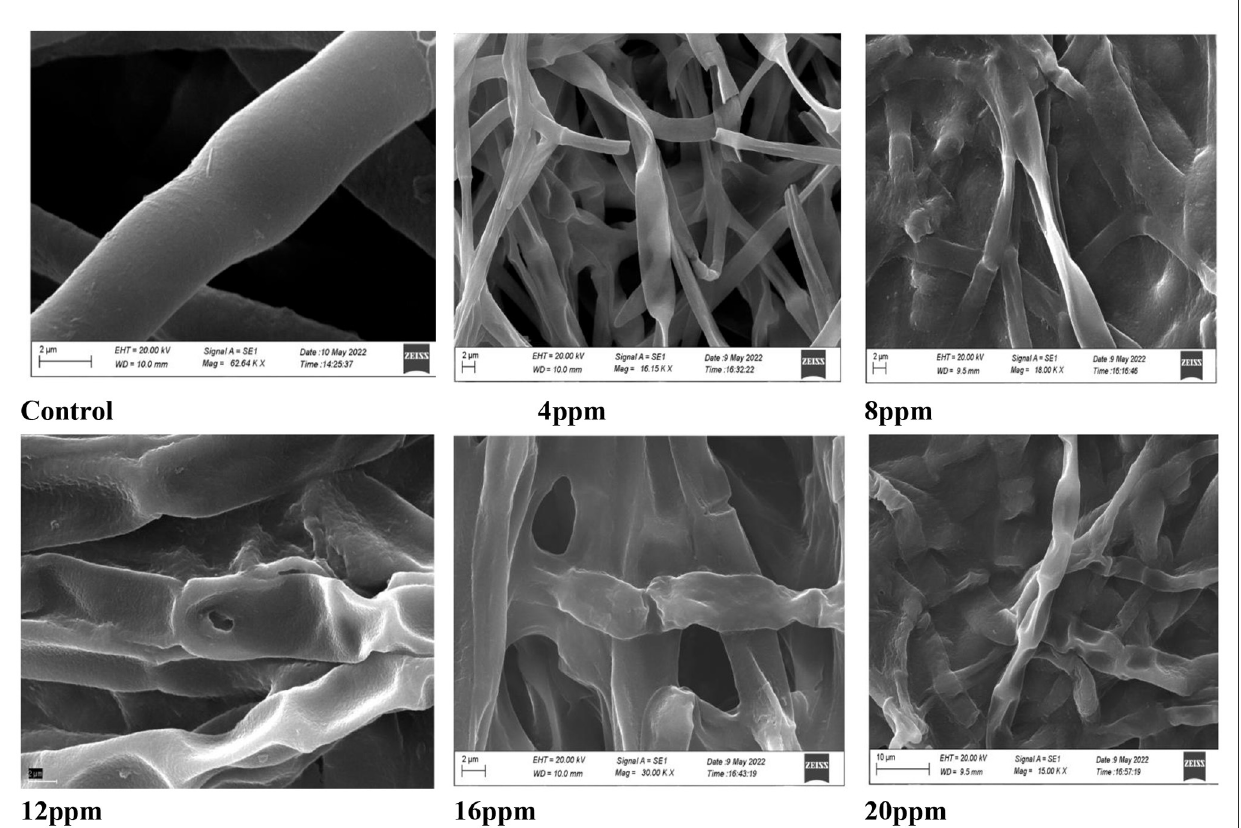
FIGURE11 Field study experimental plot at the Institute of Agricultural Sciences, BHU, Varanasi.